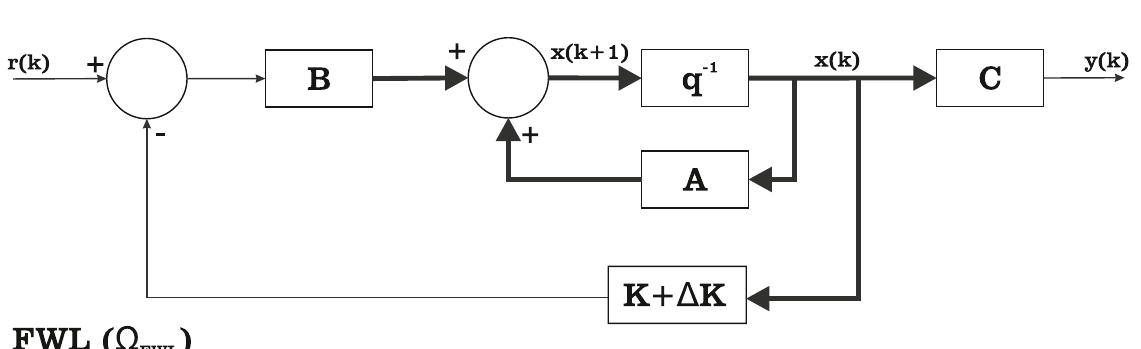
Figure 2. We illustrate the block diagram of a discrete-time feedback control system with FWL effects, where (cid:31) K denotes FWL